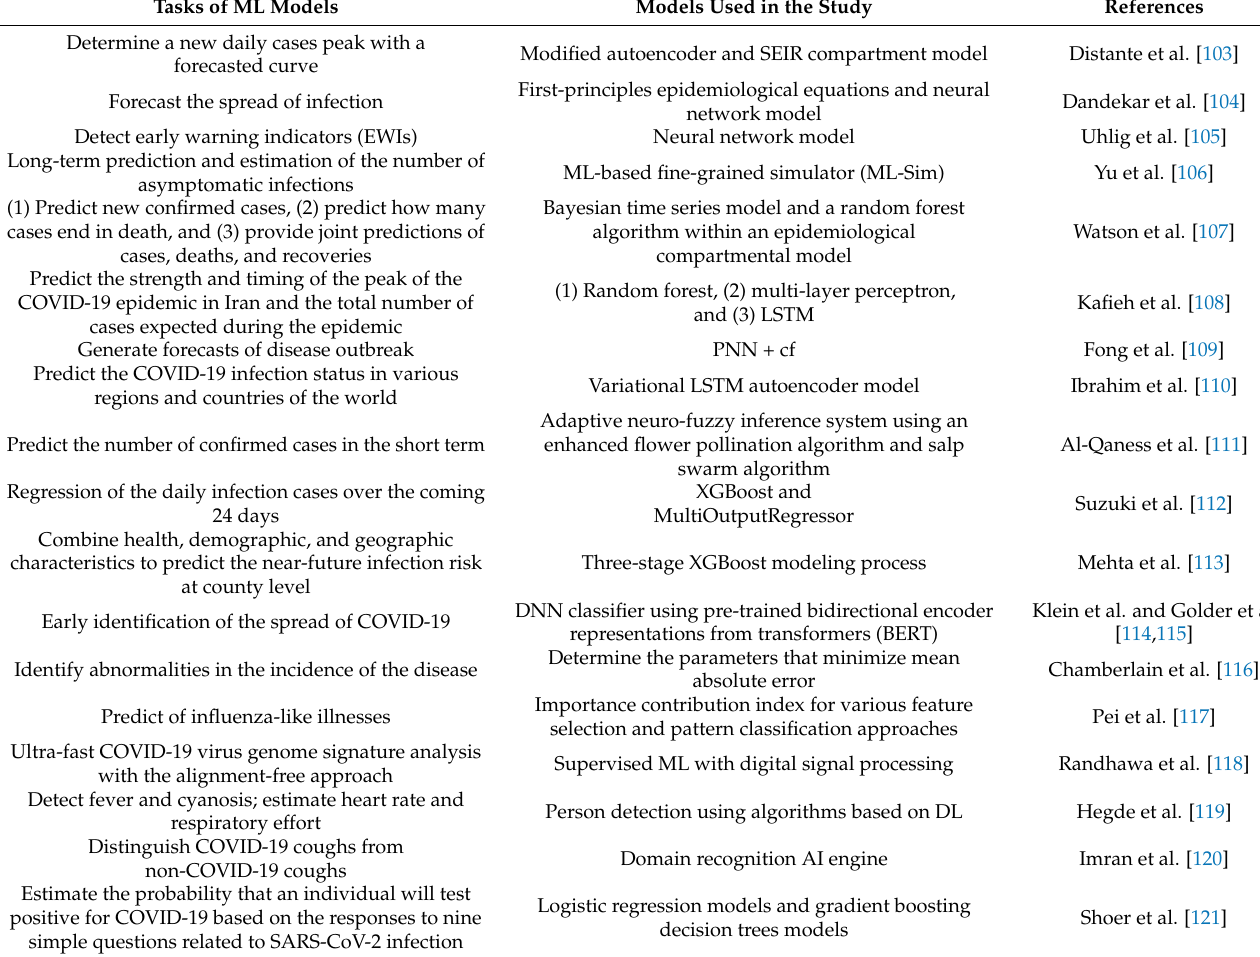
Table 1. AI approaches used to predict the dynamics of infectious diseases and the effectiveness of interventions, to detect and monitor outbreaks, and to detect infectious diseases in real